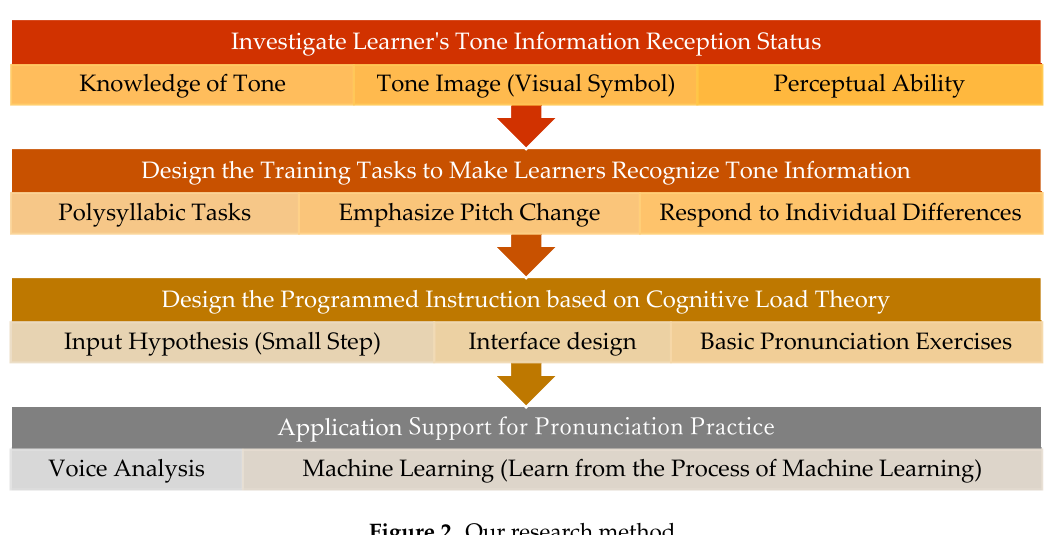
Figure 2. Our research method.